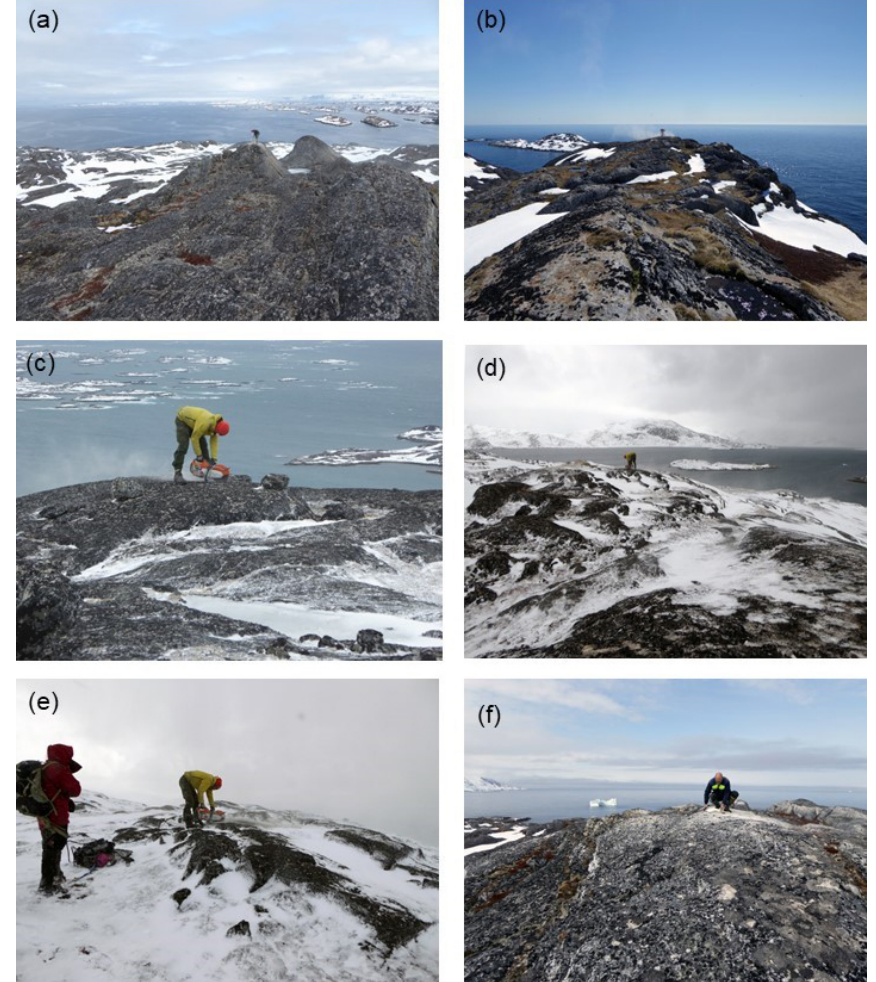
Figure 2. Sampling localities: (a) Buksefjord (sample X1526, 12.0ka), (b) Fiskenæsset (sample X1521, 13.0ka), (c) Ravns Storø (sample X1520, 17.0ka, inheritance), (d) Avigaat (sample X1518, 10.3ka), (e) Pamiut (sample X1515, 12.0ka), (f) Sermiligarssuk (sample X1507,